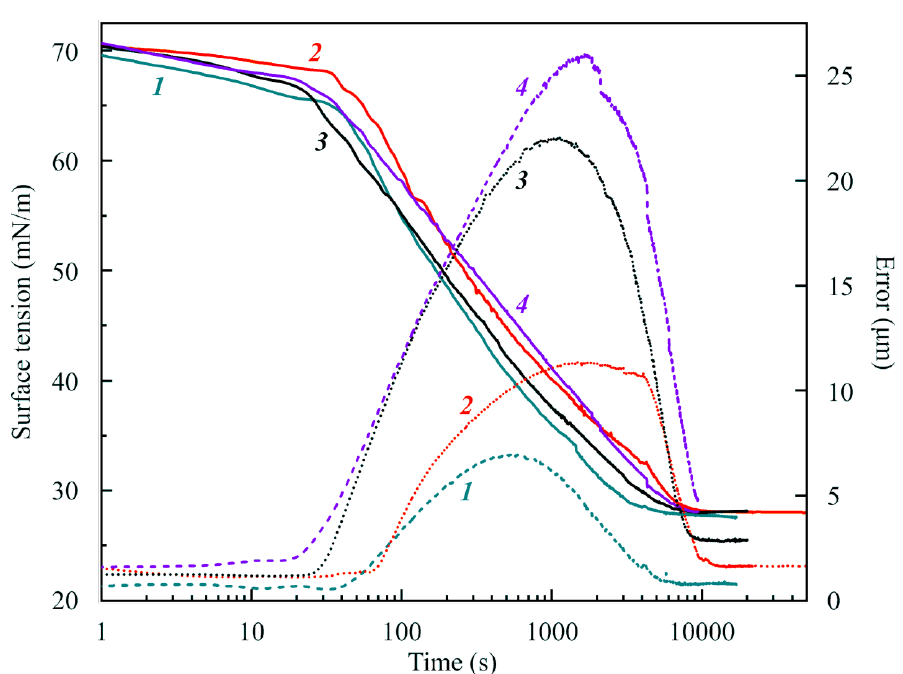
Figure 1. Dependencies of the (apparent) surface tension (solid curves) and Error (dashed curves) for water drops grown in a pure hexane vapor environment on the capillary tip of 3 mm in diameter for four values of the initial drop volume: 1 , 8.3; 2 , 10.0; 3 , 14.5; and 4 , 16.3 mm 3 . Corresponding values of drop surface area were: 17, 20, 26 and 28 mm 2 .